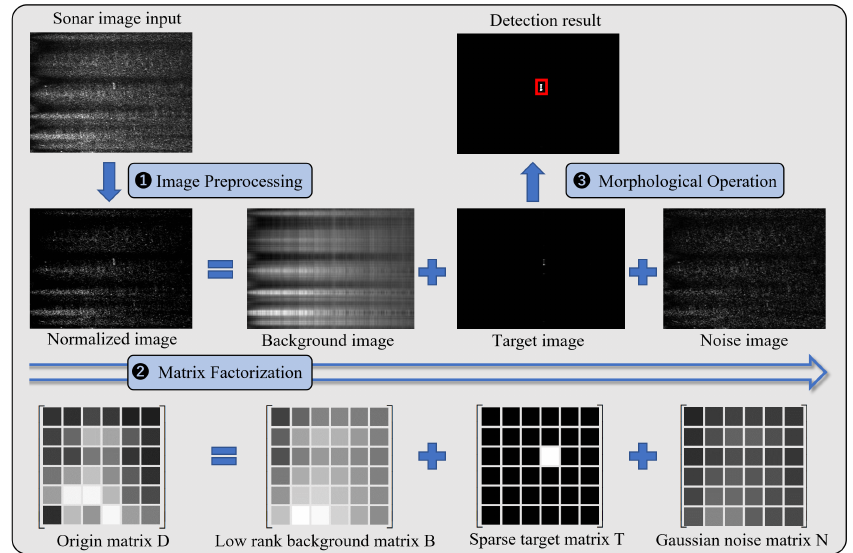
Figure 2. The flowchart of our proposed algorithm based on low-rank sparse matrix factorization. The algorithm can be divided into three parts: image preprocessing, matrix factorization, and morphological operation. The red rectangular box is the detection result.